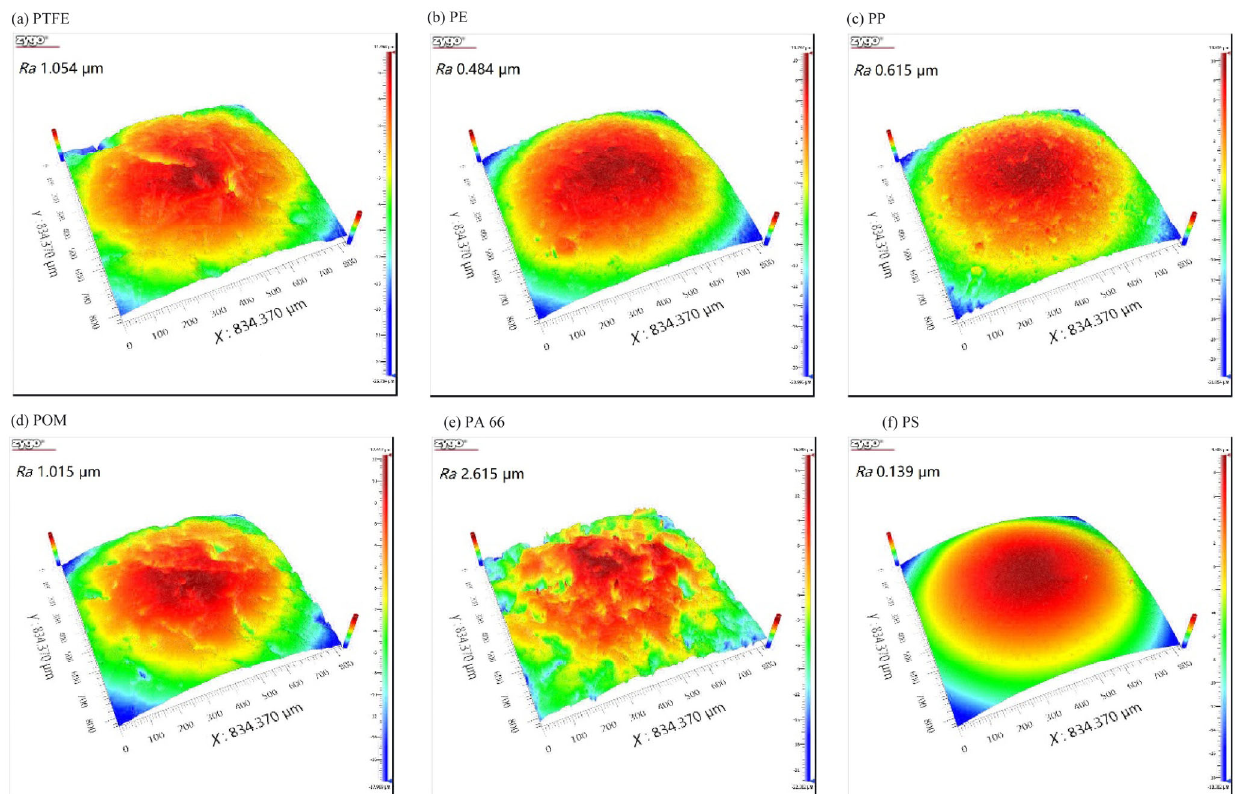
Fig. 5 Surface morphology of the polymer spheres. (a) PTFE; (b) PE; (c) PP; (d) POM; (e) PA 66; and (f)